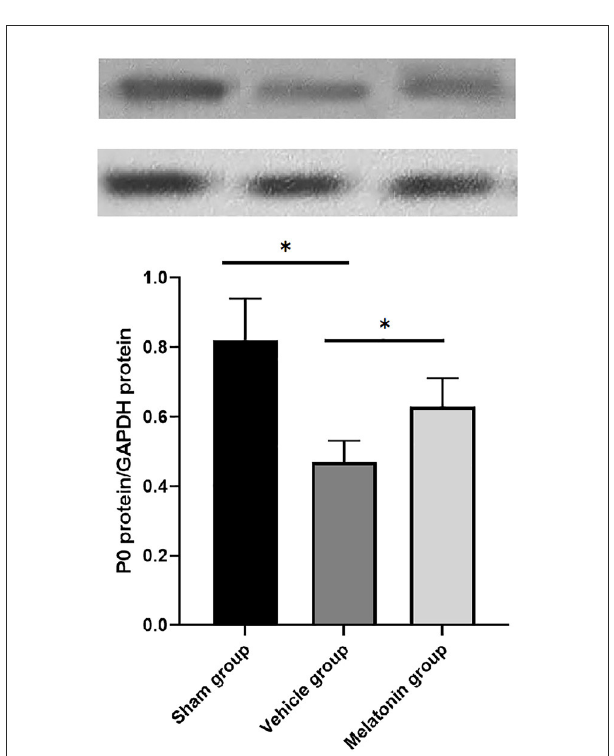
FIGURE4 P0 protein/GAPDH protein levels were assessed using western blotting in the injured sites of rats in all 3 groups, 3 weeks after injury. p -value * <